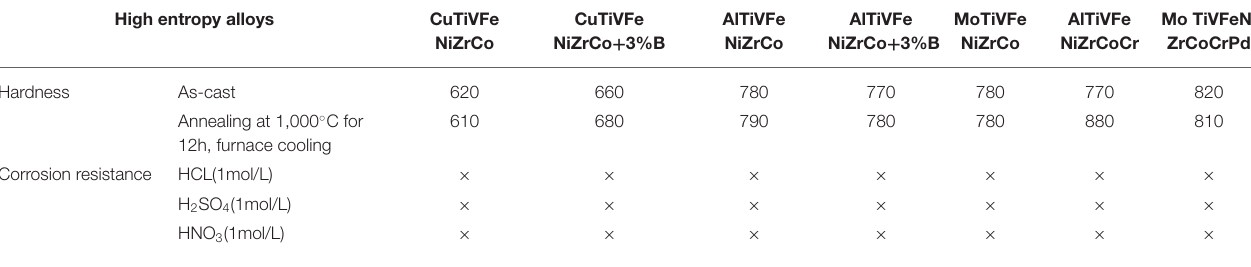
TABLE 1 | List of hardness and corrosion resistance of high entropy alloy ( × indicates no corrosion). High entropy